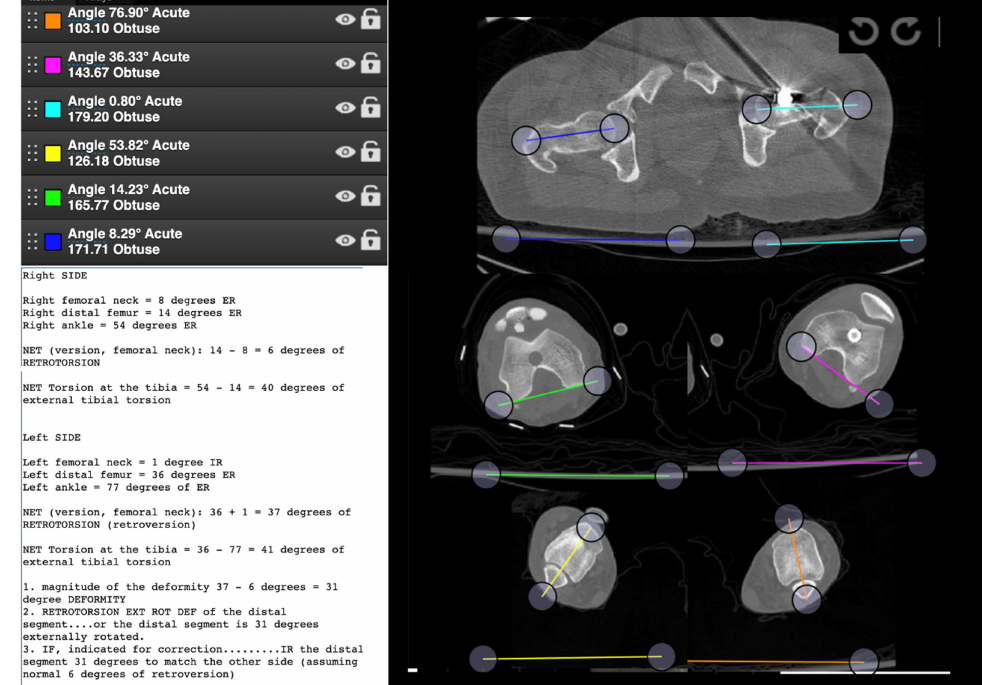
Figure 4. CT image provided during the case